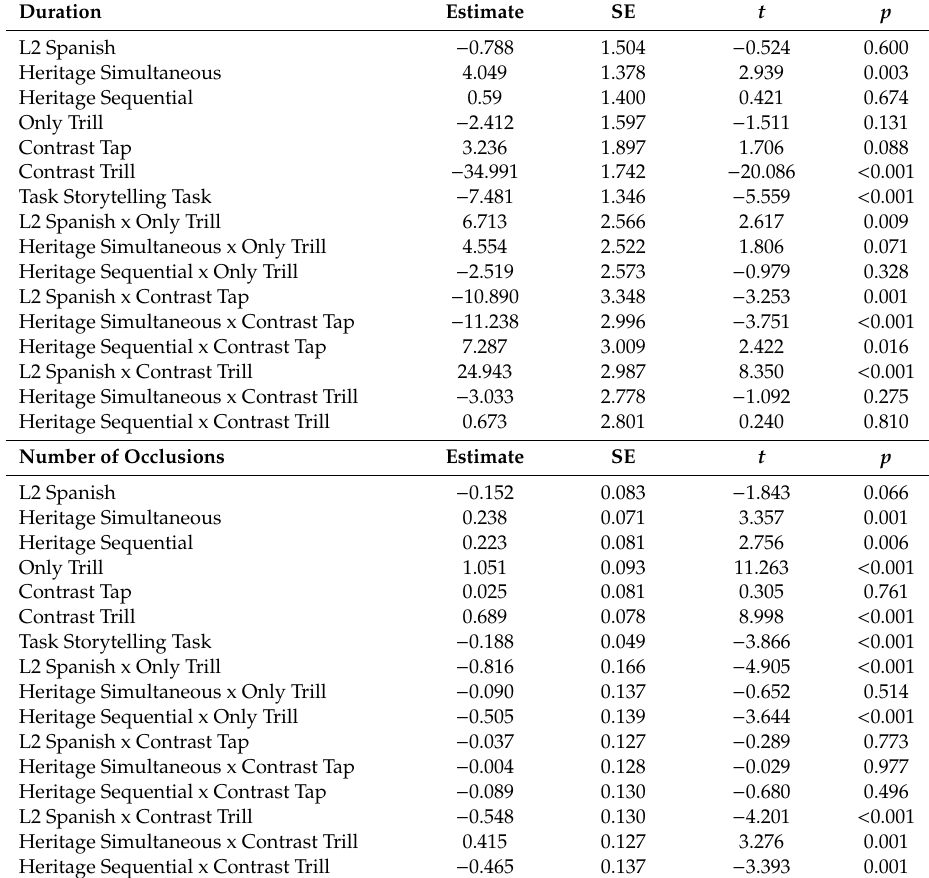
Table 2. Descriptive statistics according to rhotic duration in milliseconds and number of apical occlusions.